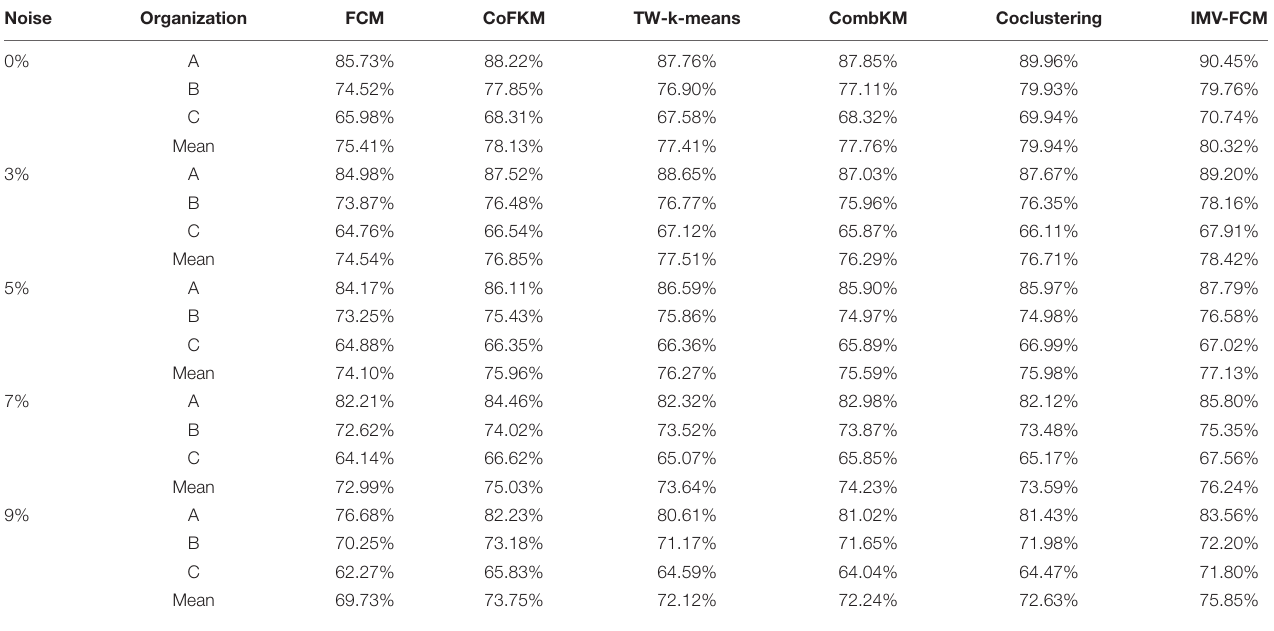
TABLE 8 | JS indicators of each algorithm